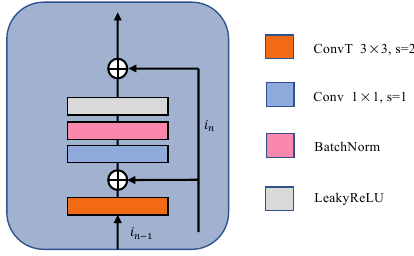
Figure 5. Intuition architecture of the SOSB module.